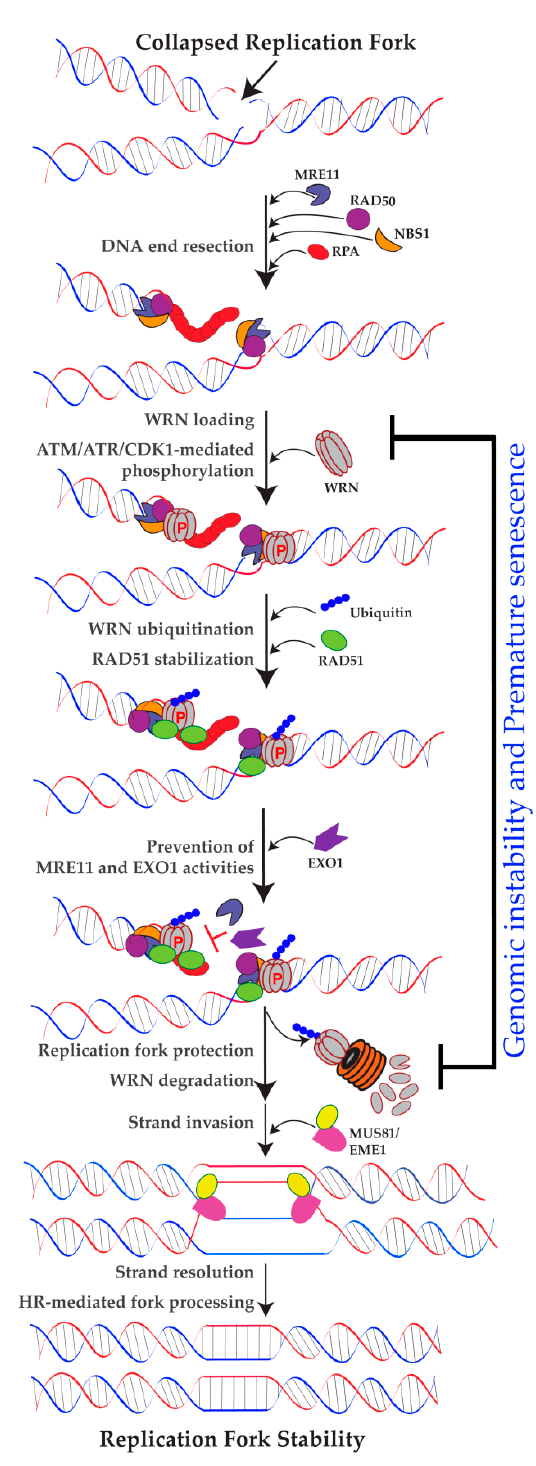
Figure 2. Diagram depicting the mechanism of WRN-mediated replication fork stabilization. WRN is recruited to the sites of collapsed replication forks and is phosphorylated at multiple Ser/Thr sites by ATM, ATR and CDK1 kinases. WRN binding to perturbed replication forks not only stabilizes RAD51 but also prevents excessive nuclease activities of MRE11 and/or EXO1. Eventually, WRN is degraded by the ubiquitin-dependent proteasomal pathway, resulting in the protection of newly replicated genome, chromosome stability and suppression of premature senescence. In the absence of WRN, replication forks will be degraded by MRE11 and/or EXO1, and that will lead to genomic instability and premature senescence. HR—homologous recombination; EXO1—exonuclease 1; RPA—replication protein A; EME1-essential meiotic structure-specific endonuclease 1; red P—phosphorylation events; ⊥ -represents blocking of nuclease activities.